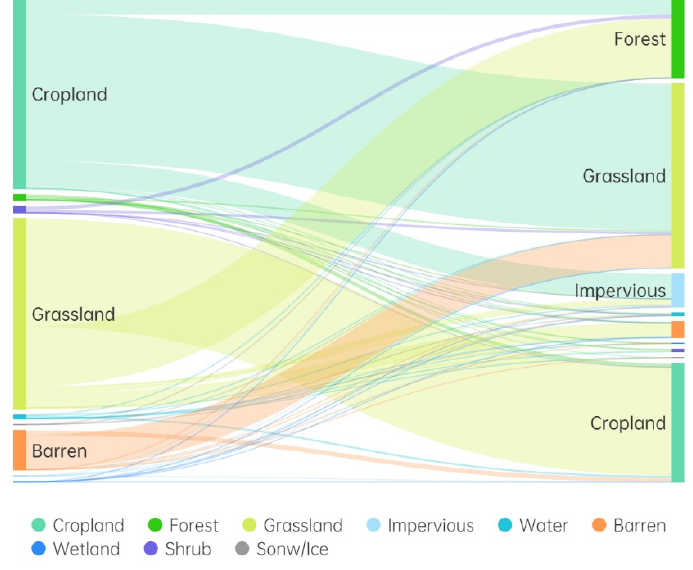
Figure 6. Shifts in land use types in buffer zone from 1985 to 2021.